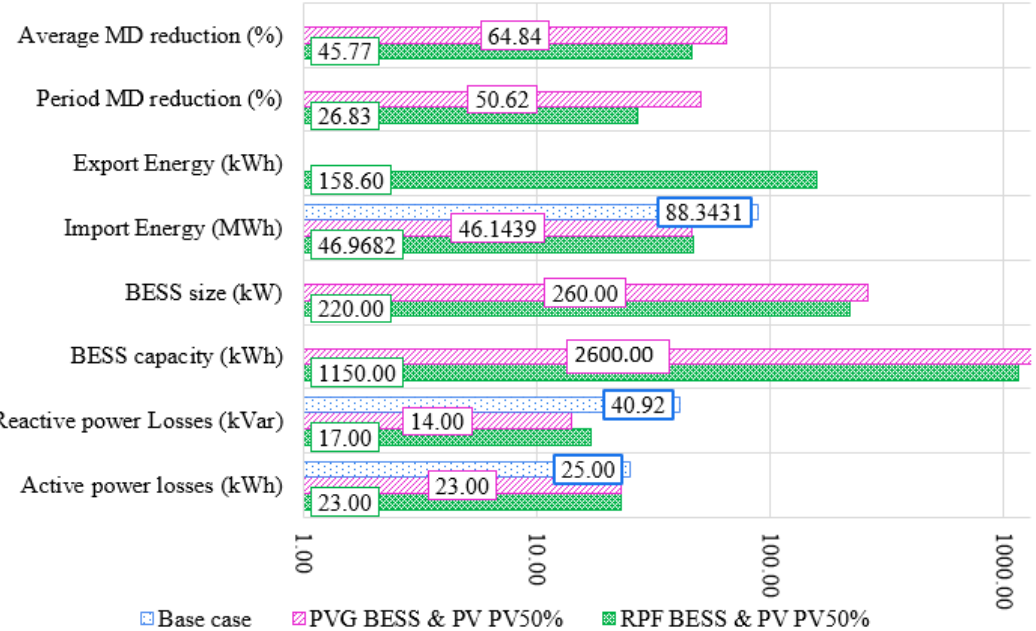
Figure A1. Comparison of PVGS and RPFS with 25% PV penetration level (January 2016).